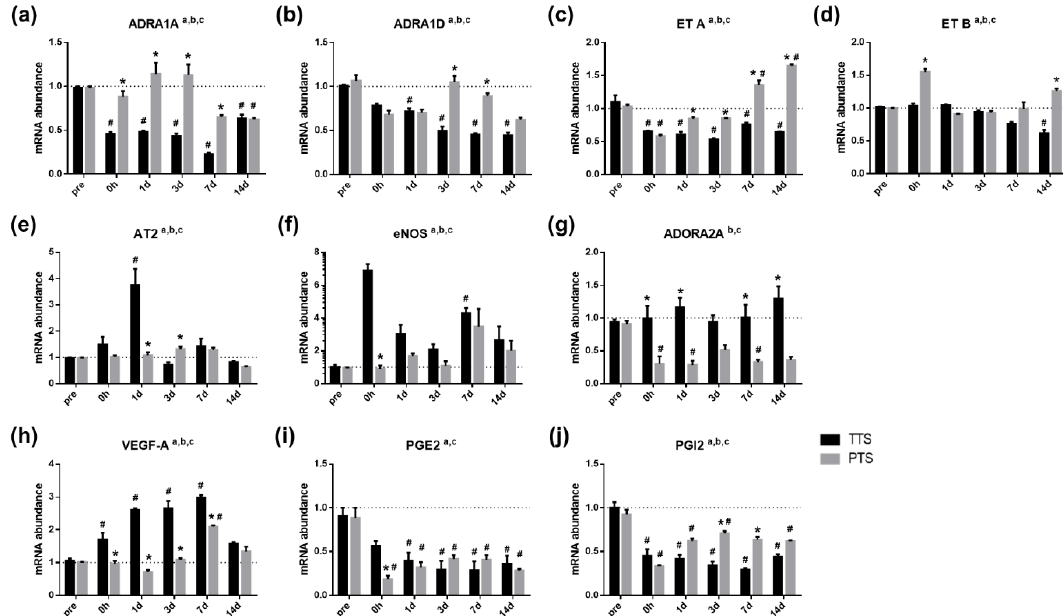
Figure 7. Genes involved in vasoconstriction and in vasodilation before (pre) and after (post) noise exposure. Effects of noise on vascular function, sensitivity to vasoconstriction ( a – d ) and vasodilation ( e – j ). a, main effect of day, p < 0.05; b, main effect of treatment (TTS, PTS), p < 0.05; and c, interaction, p < 0.05; * p < 0.05. All graphs represent mean ± S.E.M. Two-way ANOVA, Tukey’s multiple comparisons test. a, main effect of day, p < 0.05; b, main effect of treatment, p < 0.05; and c, interaction, p < 0.05. Asterisk denotes difference from TTS per day, p < 0.05; pound symbols (#) denote differences from matching normal (pre) controls, p < 0.05. n = 3–5.